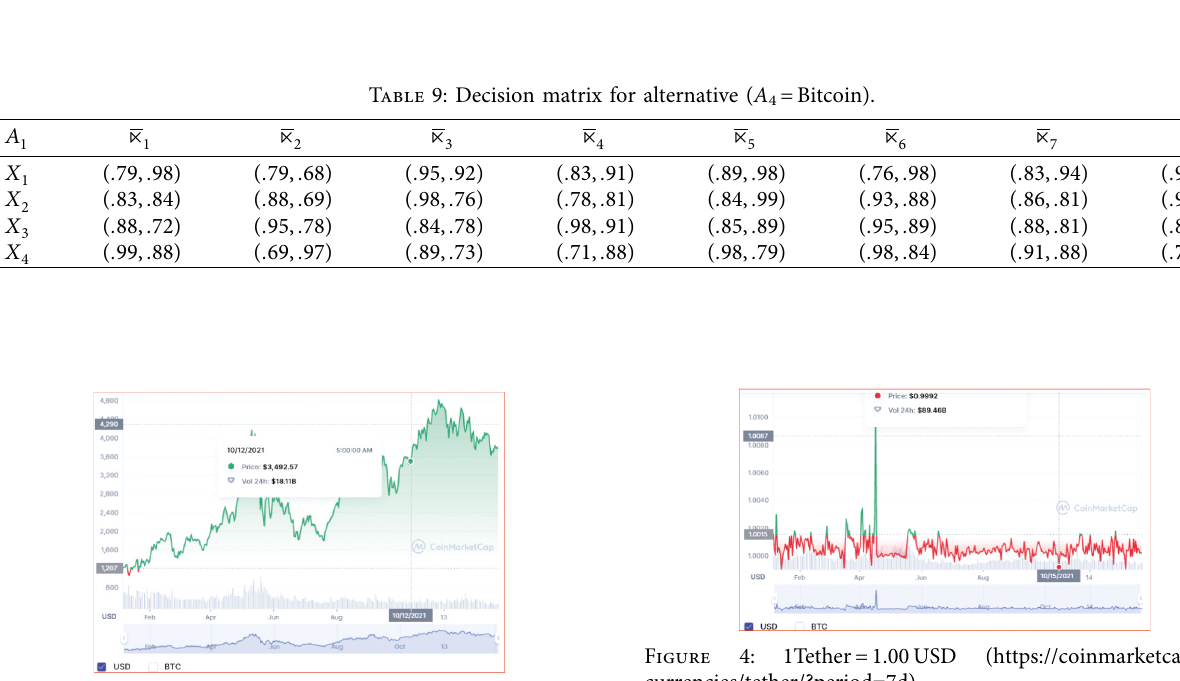
Table 8: Decision matrix for alternative ( A